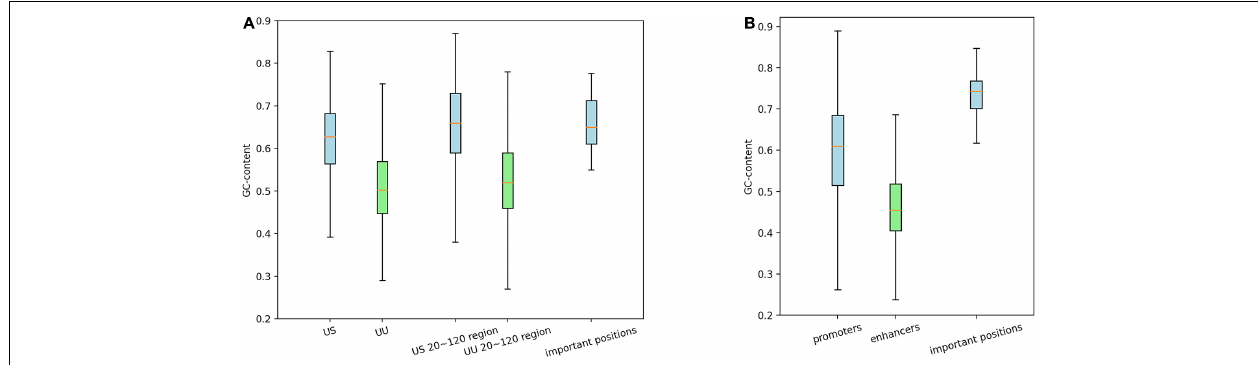
FIGURE 3 | Distribution of GCs in the regulatory regions and in the predicted important positions, which presents GC-biased characteristics in US TSS pairs (A) and in CAGE-defined promoters (B) . G, guanine; C, cytosine; TSS, transcriptional start site; US, unstable-stable TSS pair.